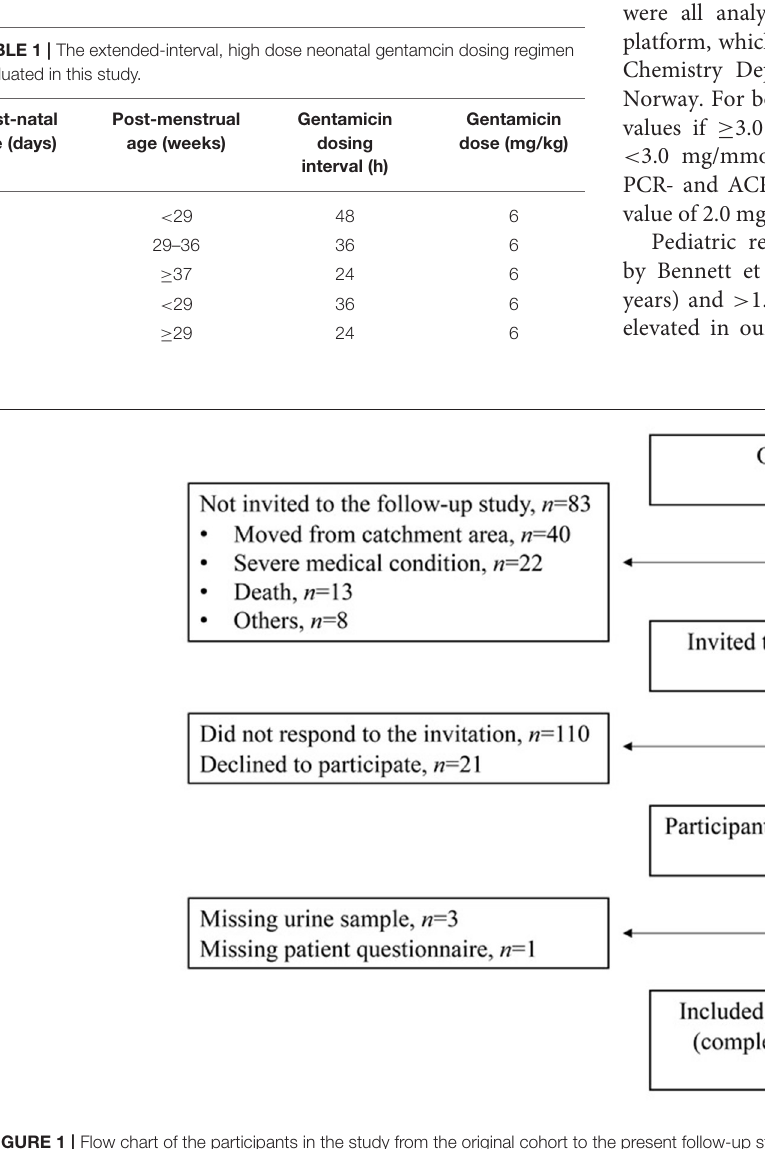
Frontiers in Pediatrics |